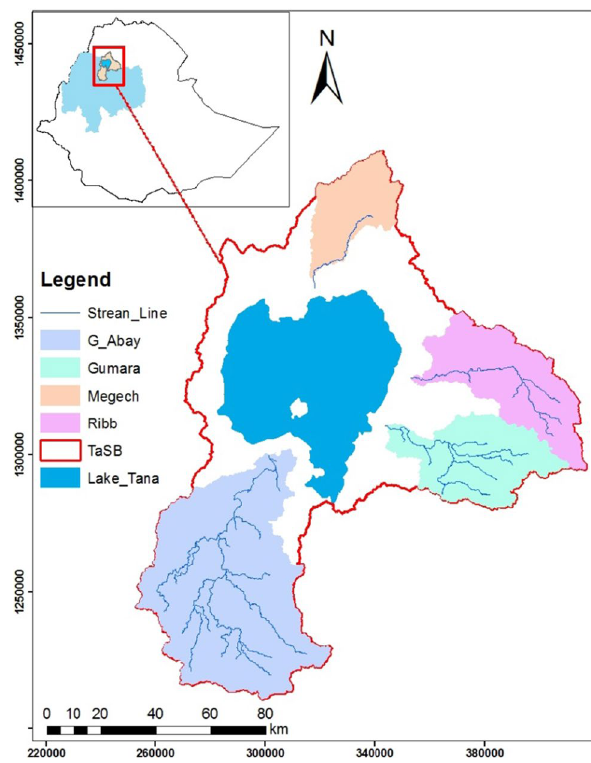
Fig. 1 Location map of review